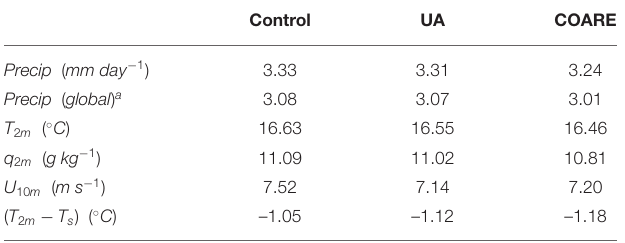
TABLE 3 | Long-term annual mean near-surface meteorology from atmosphere simulations, averaged over global oceans, unless otherwise indicated. Control UA COARE Precip ( mm day − 1